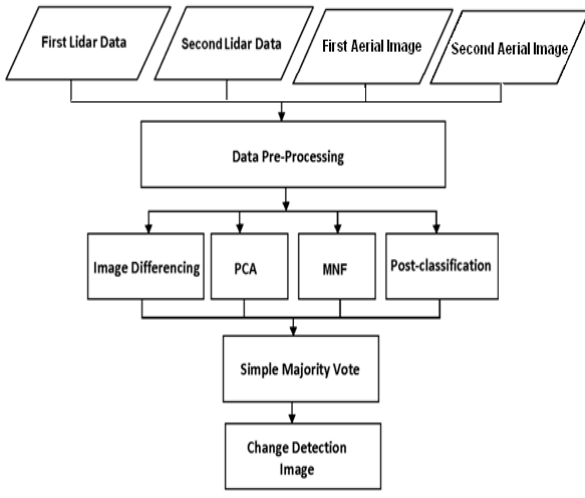
Figure 2. The workflow for change detection analysis. In the first change detection technique, differences that exceed a user-specified threshold of 10 pixels in area and 0.30 m in height, double the LiDAR system accuracy, were computed and highlighted. In the image differencing method, the second image is subtracted from the first image to provide the difference and highlight changes. The second image is more recent and the differences reflect changes over time. After application of image differencing, increases in height values that are more than the predefined thresholds, are highlighted as increases, while decreases in height values that are more than the predefined thresholds, are highlighted as decreases. The result is a grey scale image composed of a single band of continuous data that reflects the changes. The change image is